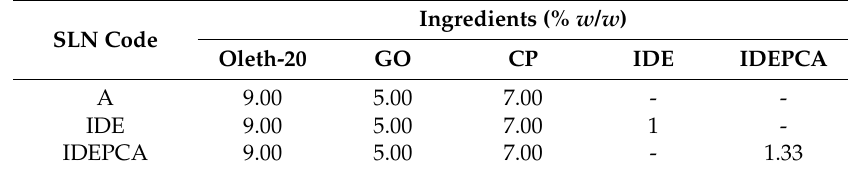
Table 2. Composition of the oil phase of unloaded and drug loaded solid lipid nanoparticles (SLN) a . SLN Code